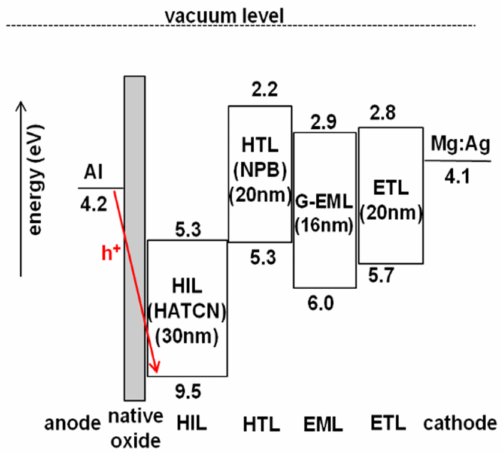
Figure 3. Energy band diagram of the proposed OLED device with Al anode and HATCN HIL.